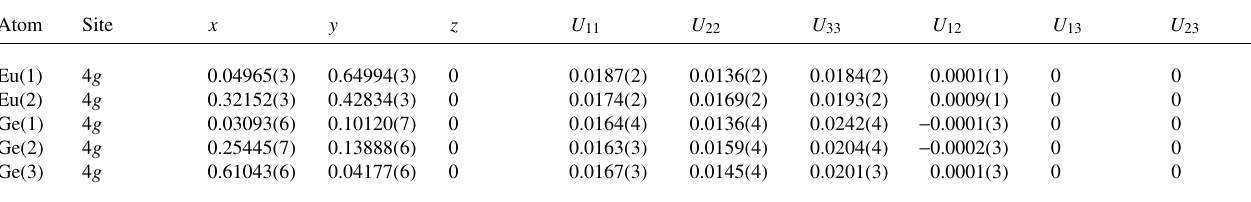
Table 3. Atomic coordinates and displacement parameters (in Å 2 )